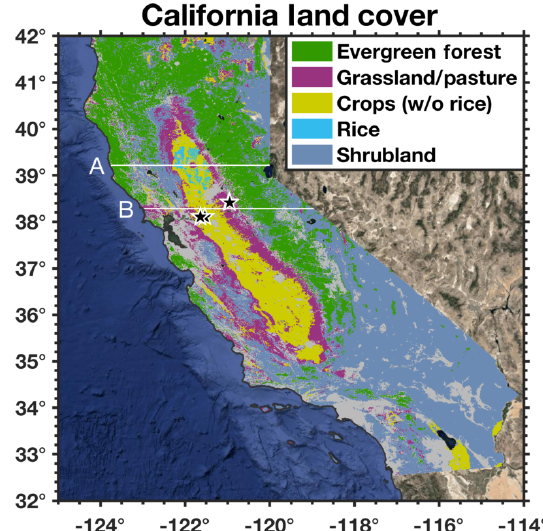
Figure 1. Land cover in California from the 2018 USDA Crop- Scape database (USDA, 2018). Resolution has been degraded from the native 30m resolution to 500m for comparison with TROPOMI data. Coloring indicates that a land type makes up more than 50% of the 500m grid cell. White lines are the locations of two tran- sects across California for Hovmöller diagrams: 39.218 ◦ N (tran- sect A) and 38.282 ◦ N (transect B). Black stars show the location of six AmeriFlux sites: Bouldin Island (38.1090 ◦ N, 121.5350 ◦ W; US-Bi2), Tonzi Ranch (38.4316 ◦ N, 120.9660 ◦ W; US-Ton), Vaira Ranch (38.4133 ◦ N, 120.9507 ◦ W; US-Var), Twitchell Island West Pond (38.1074 ◦ N, 121.6469 ◦ W; US-Tw1), Twitchell Island East End (38.1030 ◦ N, 121.6414 ◦ W; US-Tw4), and Twitchell Island East Pond (38.1072 ◦ N, 121.6426 ◦ W;